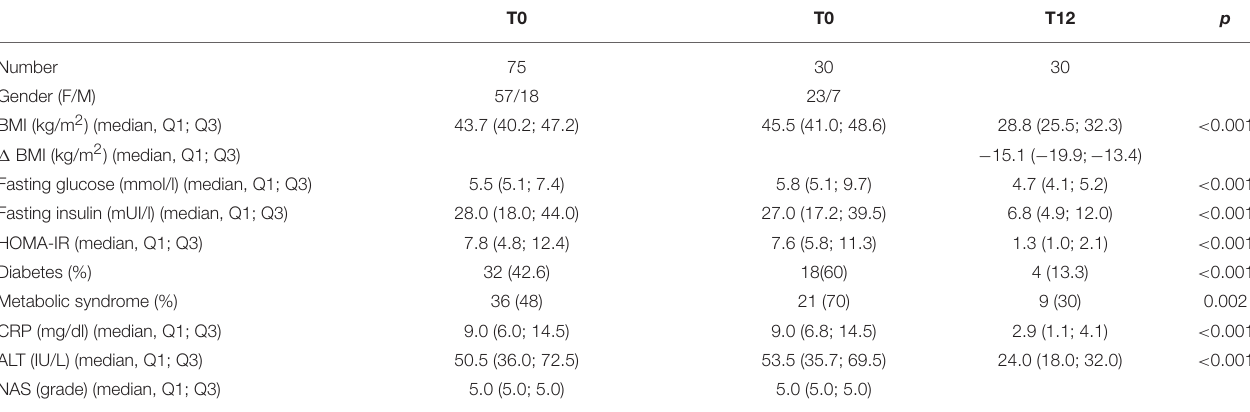
TABLE 2 | Patients’ clinical and biochemical parameters at baseline and after a 12-month follow-up period (patients without a second liver biopsy). T0 T0